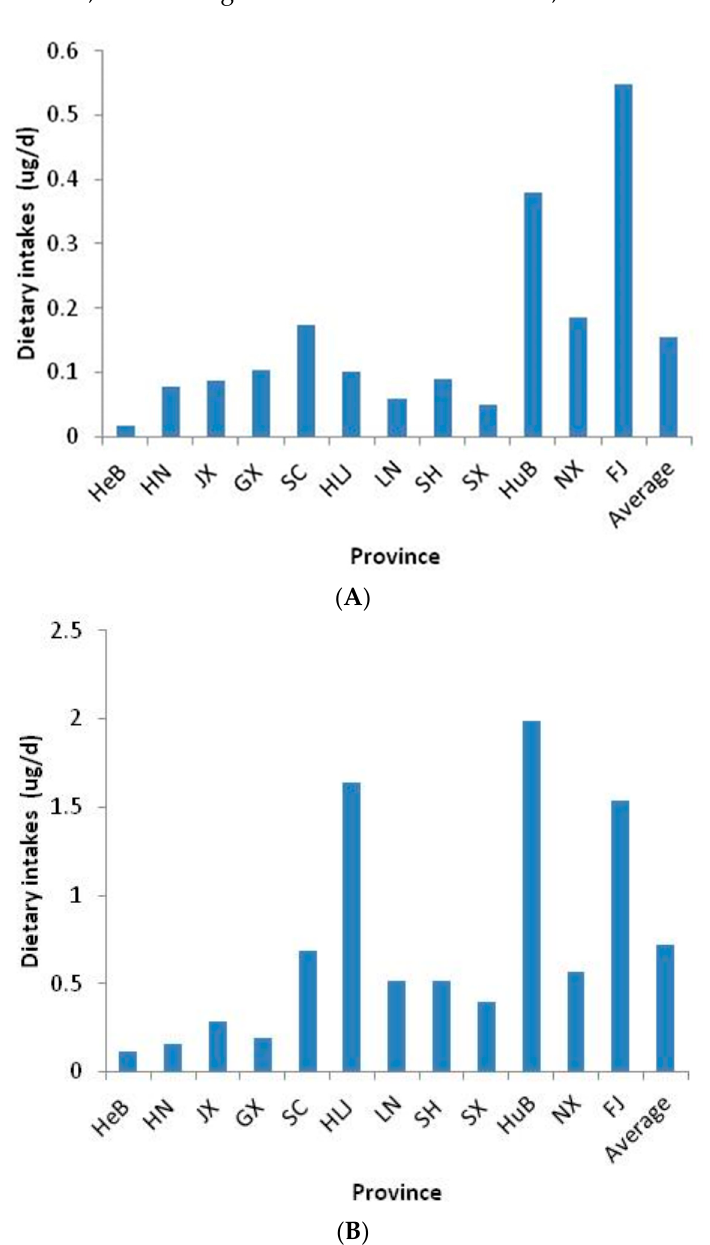
Figure 3. The estimated daily intakes of cortisone ( A ) and cortisol ( B ) from aquatic food from the Chinese TDS.